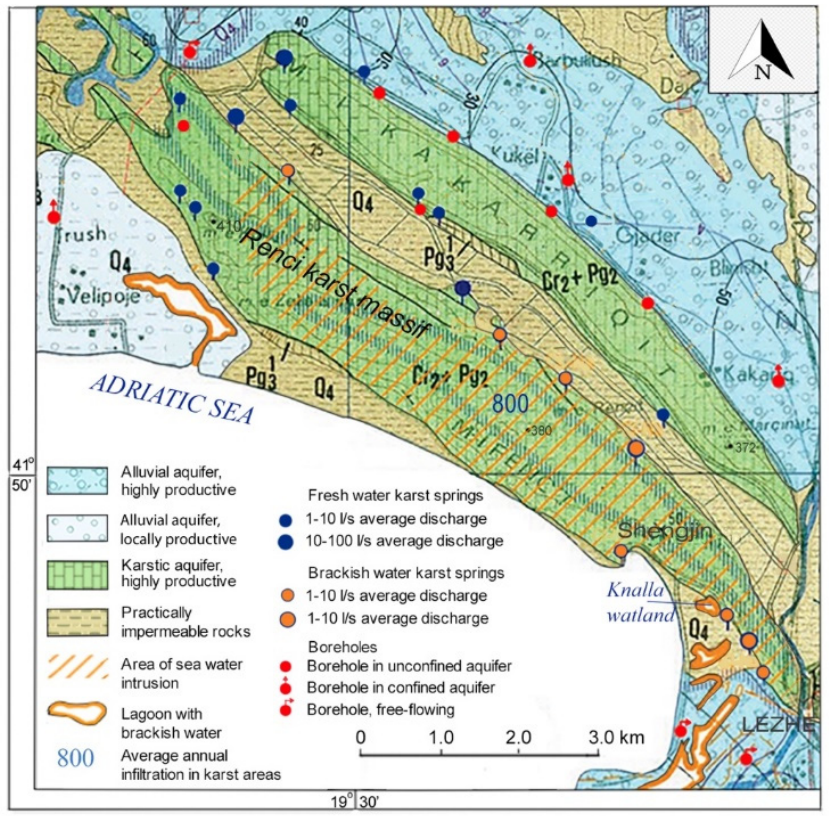
Figure 7. Hydrogeological map of the Renci structure (modified after